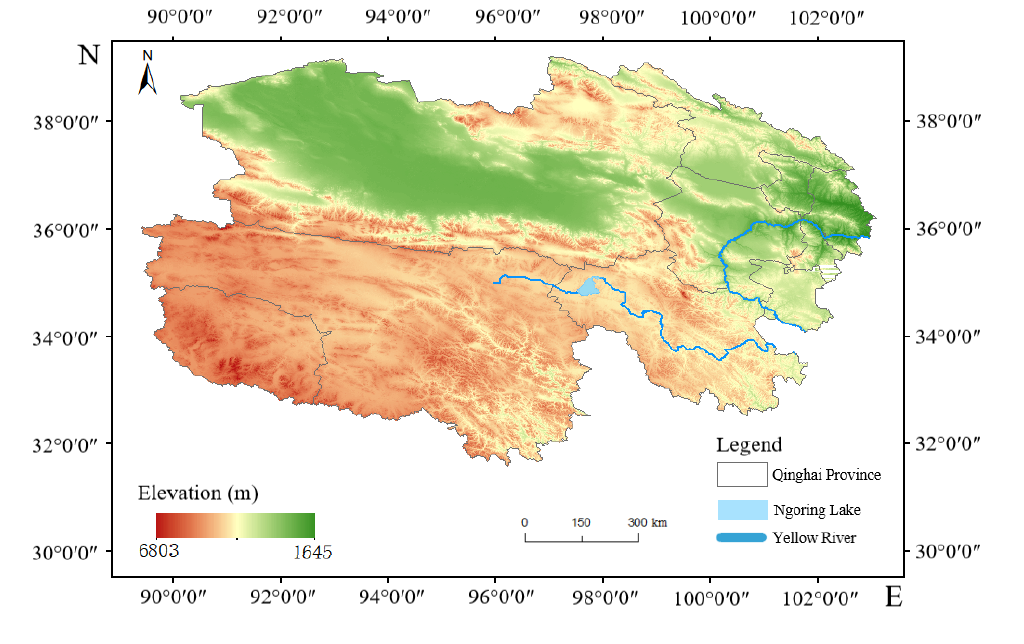
Figure 1. Geographical Location and Scope of Ngoring Lake in Qinghai